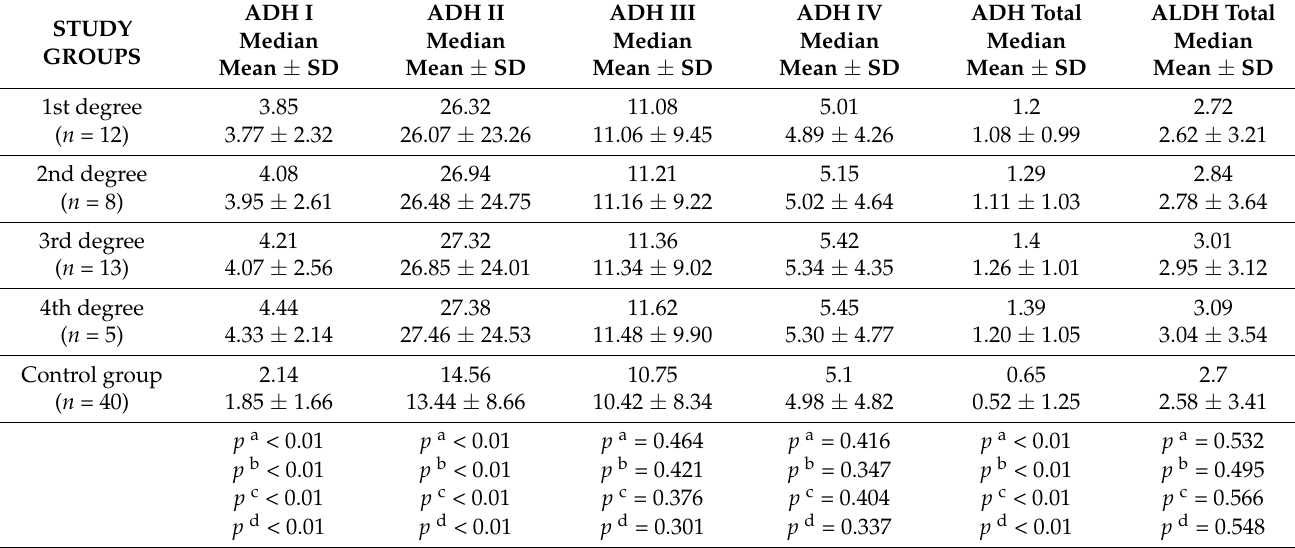
Table 2. Activity of ADH and ALDH in the serum of patients with fatty liver depending on the degree of cirrhosis in accordance with the METAVIR classification.